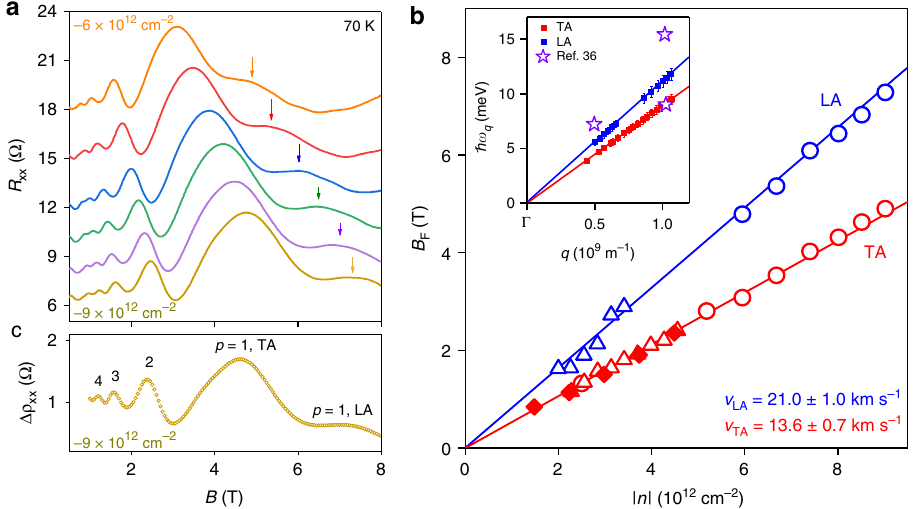
Fig. 4 Phonon spectroscopy in graphene by measurement of magnetophonon oscillations. a Longitudinal resistance R xx as a function of B measured for several high n of holes in our wide ( W = 13.8 μ m) dual-gated graphene Hall bar. The curves have been off-set vertically for clarity. b Red symbols plot the fundamental frequency B F ≡ pB p of magnetophonon oscillations as a function of absolute n for three different devices; open circles correspond to the dual- gated device which allowed high doping. The blue symbols mark the positions B p = 1 of the broad peak (indicated by coloured arrows in a ) which appears clearly at high n . The red and blue solid lines represents Eq. (1) with v s / v F = 0.0128 and 0.0198 respectively. Knowing v F (Supplementary Note 5) we extract the TA ( v TA ) and LA ( v LA ) phonon velocities. Inset: Data in main panel transformed to phonon dispersion curves. Coloured squares − experimental data points (error bars re fl ect the error in the experimentally extracted v F ), solid lines plot the equation ħ ω q = ħ v s q (same v s as in the main panel), purple stars — data taken from ref. 36 . c Calculation of the oscillatory part of the resistivity Δ ρ xx ( Ω ) using the Kubo formula (see Supplementary Note 6 for